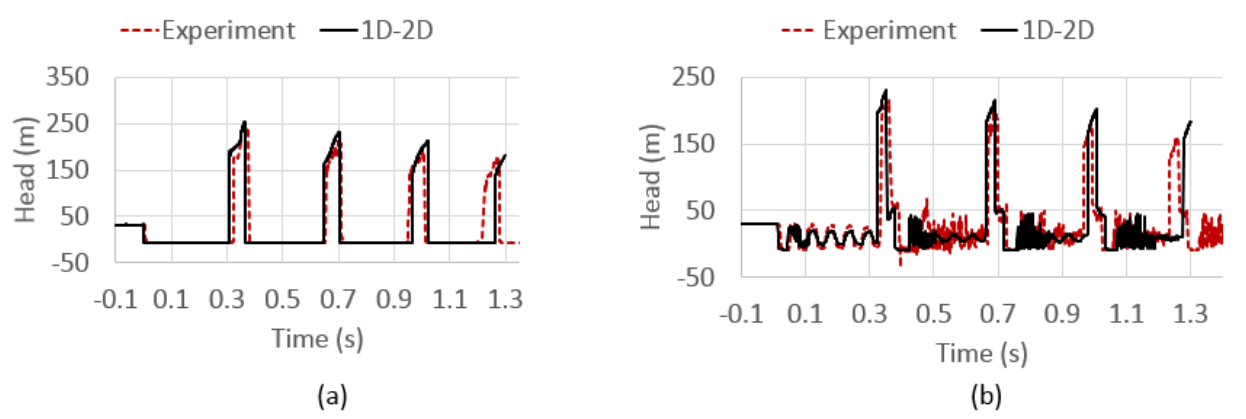
Figure 5. pressure time histories calculated by DGCM at; ( a ) valve; ( b ) pipe mid-point.